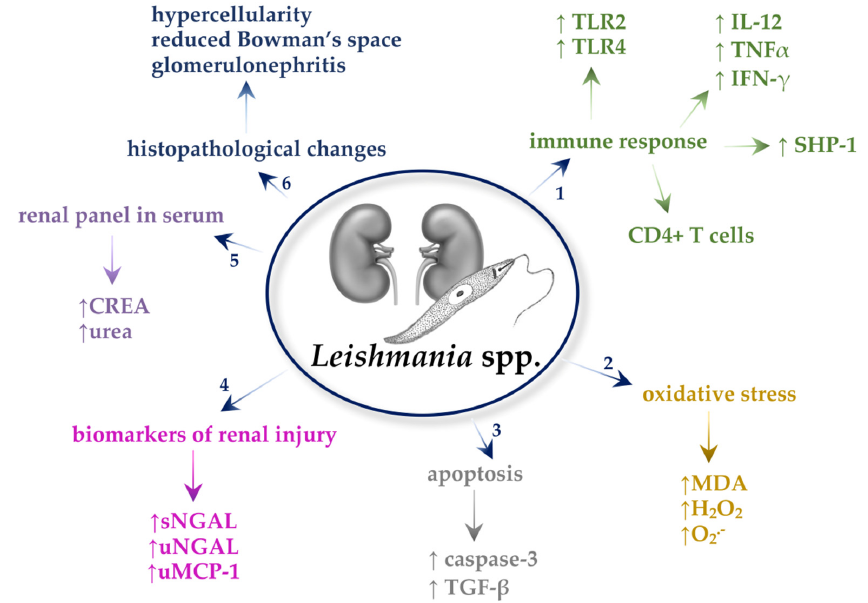
Figure 1. Mechanisms in Leishmania spp.-infected kidneys. 1. Leishmania spp. increase the expression of Toll-like receptors (TLRs), mainly TLR2 and TLR4, and they also affect the growth of interleukin-12 (IL-12), tumor necrosis factor- α (TNF- α ), and interferon- γ (IFN- γ ). It was found that Leishmania spp. increase SHP-1 activity in the kidneys of hosts. The inflammatory cells, which are observed in the kidneys of hosts infected with Leishmania spp., are CD4+ T cells. 2. Leishmania spp. cause oxidative stress manifested by an increase in malondialdehyde (MDA), H 2 O 2 , and O 2– . 3. Leishmania spp. cause an increase in caspase-3 activity, the main enzyme in the process of apoptosis, and an increase in transforming growth factor β (TGF- β ) level, an apoptotic inducer. 4. Biomarkers, which increase in nephropathy caused by Leishmania spp., are serum and urine neutrophil gelatinase-associated lipocalin (sNGAL and uNGAL, respectively) and monocyte chemoattractant protein-1 in the urine (uMCP-1). 5. Leishmania spp. cause an increase in creatine (CREA) and urea levels in the serum of hosts. 6. The parasites cause hypercellularity, reduced Bowman’s space, and glomerulonephritis in the kidneys.